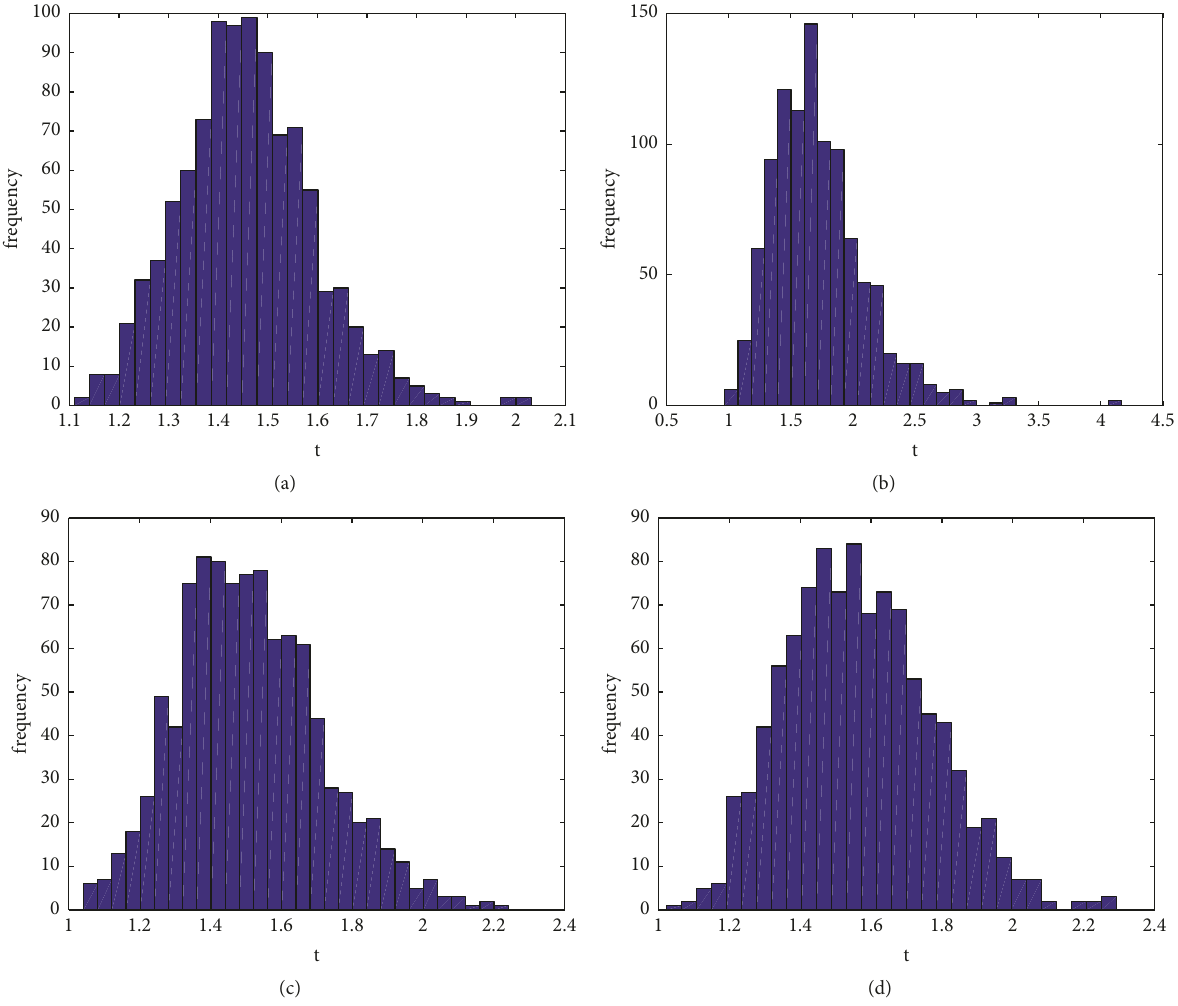
Figure 7: The effects of the environmental perturbation intensity on pest-outbreak frequency; parameters are fixed as 𝑟 = 1, 𝐾 = 10,𝑎 = 2, 𝜇 = 0.2,𝐷 = 0.1, 𝐸𝑇 = 7.5, 𝜃 = 0.4,𝜏 = 0 , and (a) 𝛼